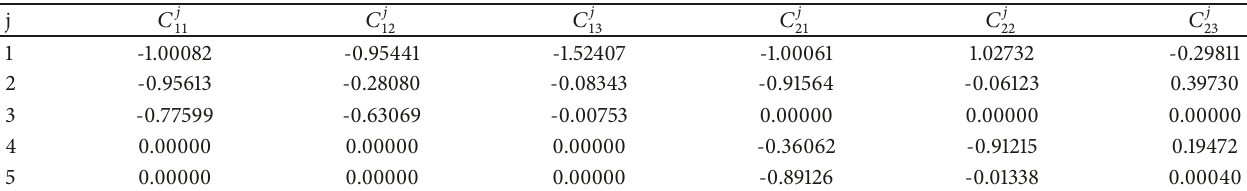
Table 1: Values of the control parameters 𝐶 𝑖𝑗